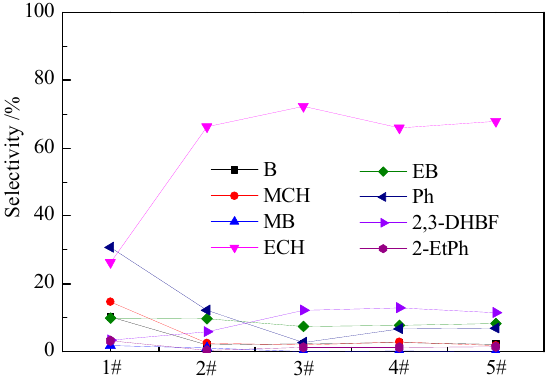
Figure 7. Production distribution of Ni x Cu (10- x ) / γ -Al 2 O 3 ( x = 0, 3, 5, 7, 10) catalysts at 8 h (1#-Ni/ γ -Al 2 O 3 ; 2#-Ni 7 Cu 3 / γ -Al 2 O 3 ; 3#-Ni 5 Cu 5 / γ -Al 2 O 3 ; 4#-Ni 3 Cu 7 / γ -Al 2 O 3 ; 5#-Cu/ γ -Al 2 O 3 ) (reaction conditions: T = 300 °C, p = 3.0 MPa, WHSV = 4.0 h − 1 , and H 2 /oil = 500(V/V)).